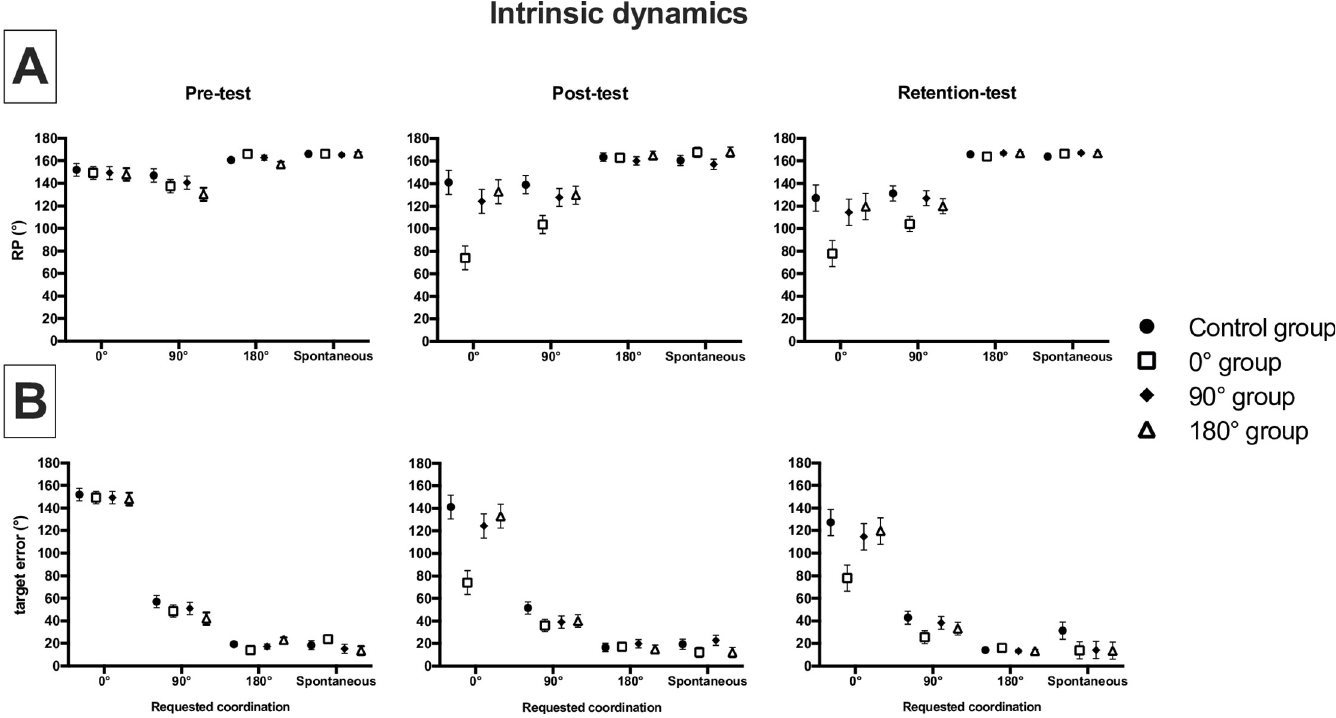
Fig 3. Depictions of coordination intrinsic dynamics: Absolute target error of trunk/horse RP (mean ± standard error) for each group at each requested coordination patterns during pre- (left panel), post- (middle panel) and retention tests (right panel).